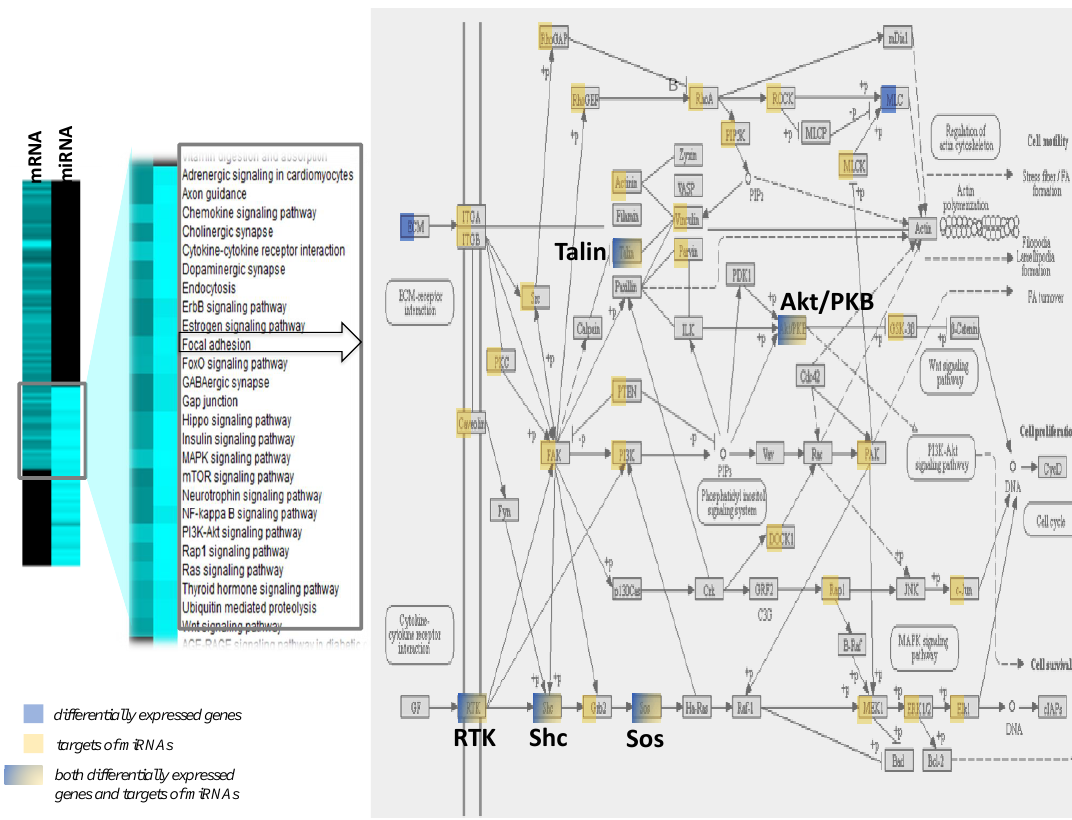
Figure 5. E ff ect of lipid injury on microRNA target di ff erentially expressed gene pathways expression in hippocampal microvessels. Heat map of di ff erentially expressed gene pathways and miRNA target gene pathways. Comparisons of pathways of di ff erentially expressed genes and pathways of miRNA target genes identified a group of pathways such as the chemokine signaling pathway, focal adhesion, gap junction, insulin signaling, Nf-kB signaling or Gap junctions, and pathways that regulate endothelial cell interaction and permeability in common. The representative integrated analysis of the di ff erentially expressed genes, and target genes of di ff erentially expressed miRNAs for the focal adhesion signaling pathway is detailed. Blue = di ff erentially expressed genes; yellow = target genes of di ff erentially expressed miRNAs; color gradation from blue to yellow = genes identified to be both di ff erentially expressed and to be targets of di ff erentially expressed miRNAs.